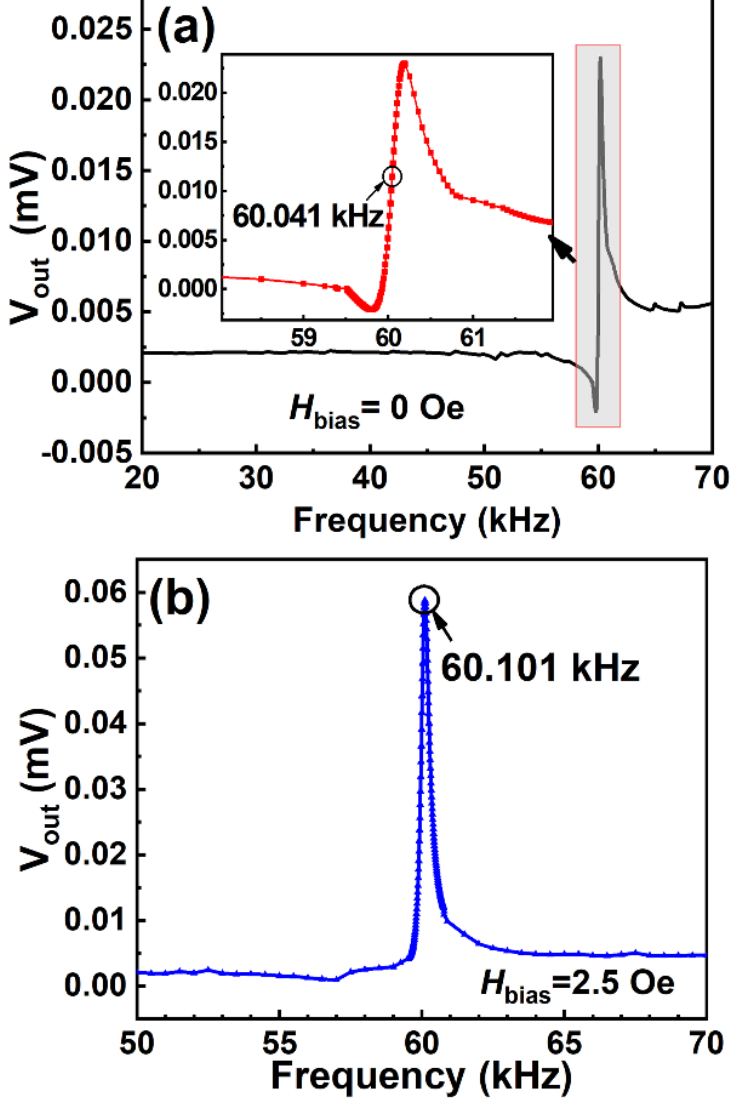
Figure 2. The frequency dependence of V out of the ME sensor without DC bias field H bia = 0 Oe ( a ) and with H bias = 2.5 Oe ( b ). The inset of Figure 2a is a magnified view of the vicinity of the resonance peak.